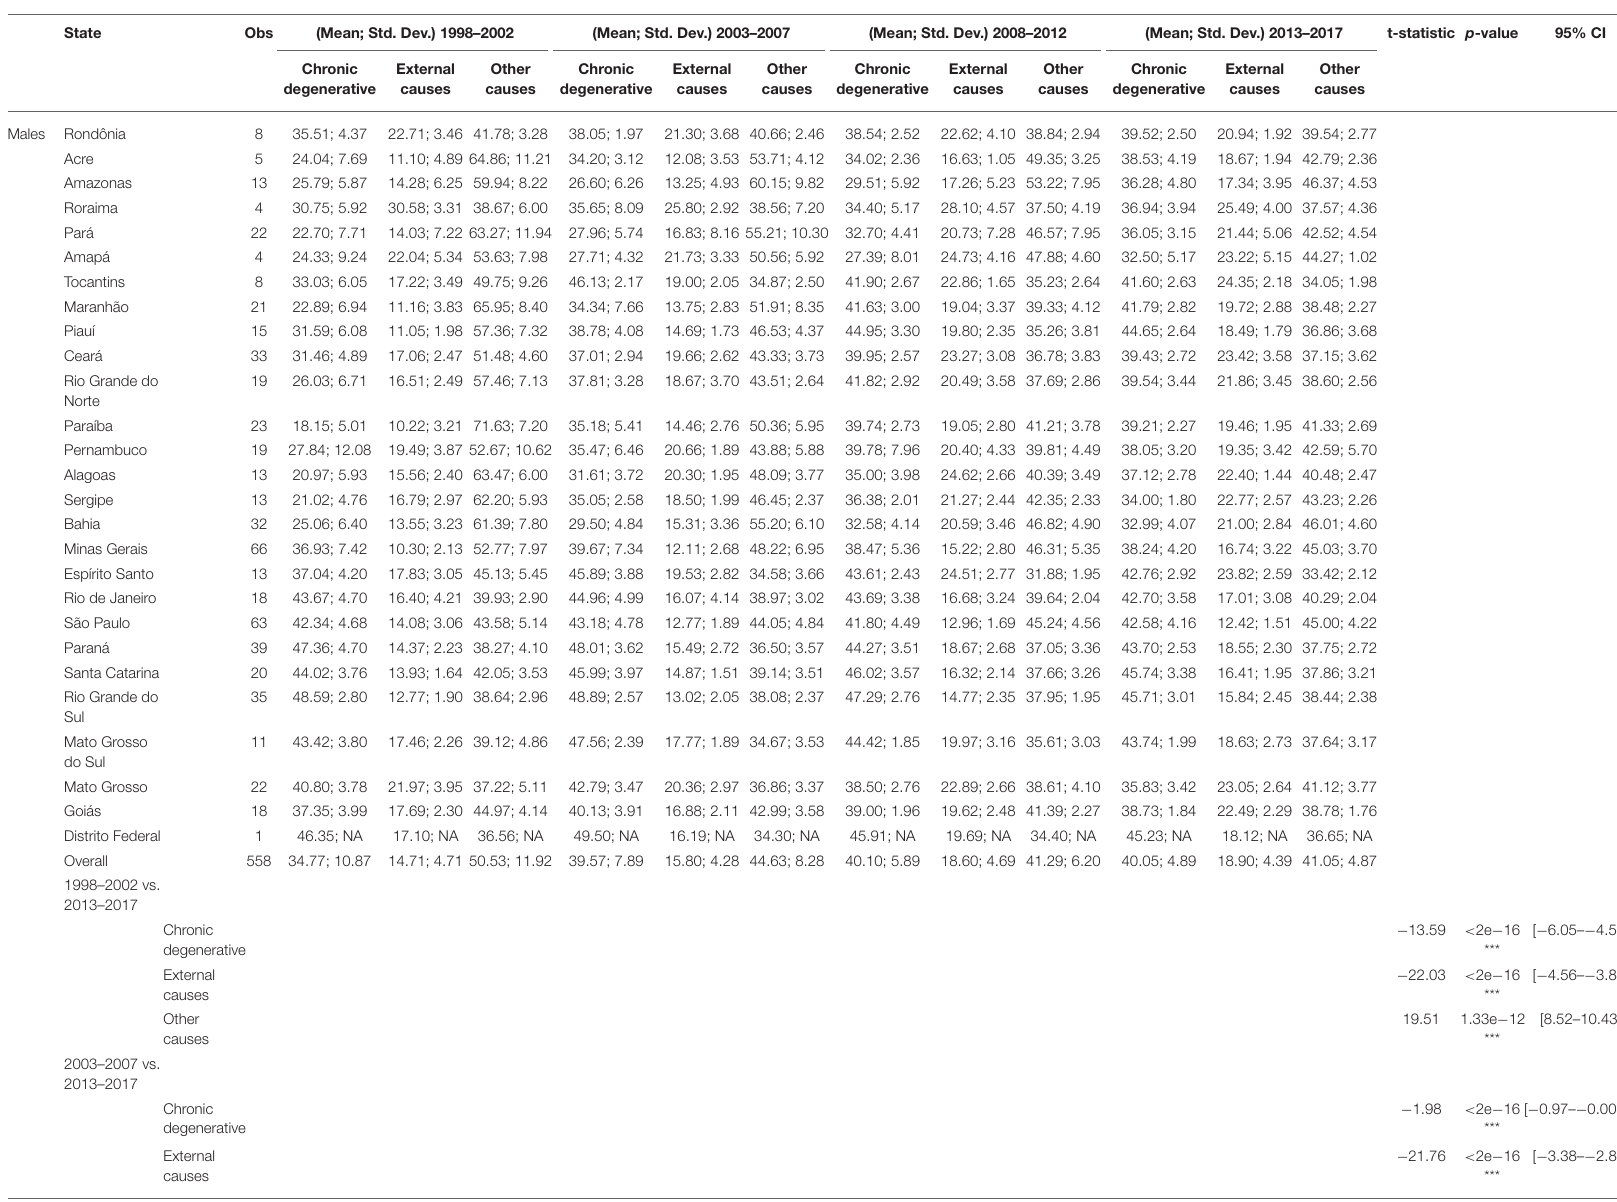
TABLE 1 | Descriptive statistics – chronic degenerative, external causes, and other causes, by sex and period.